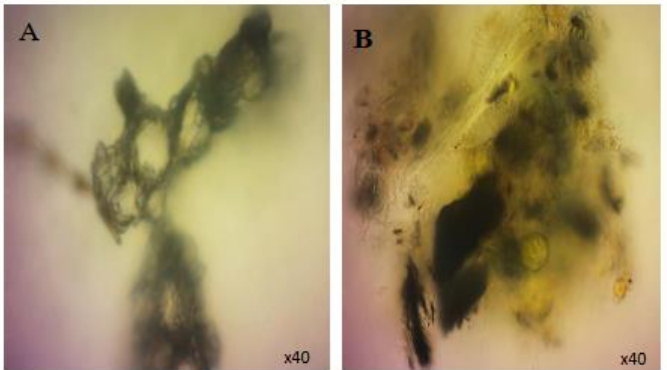
Figure 11. Light micrographs of faecal and pseudofaecal algal cells. ( A ) shows Pseudofaecal material expelled by the exhalant siphon of the mussels when fed the SWCNTs 500 µgL − 1 alone, while figures ( B ) shows pseudofaecal algal cells and SWCNTs expelled by the exhalant siphon of the mussel when fed SWCNTs and Tetraselmis suecica.